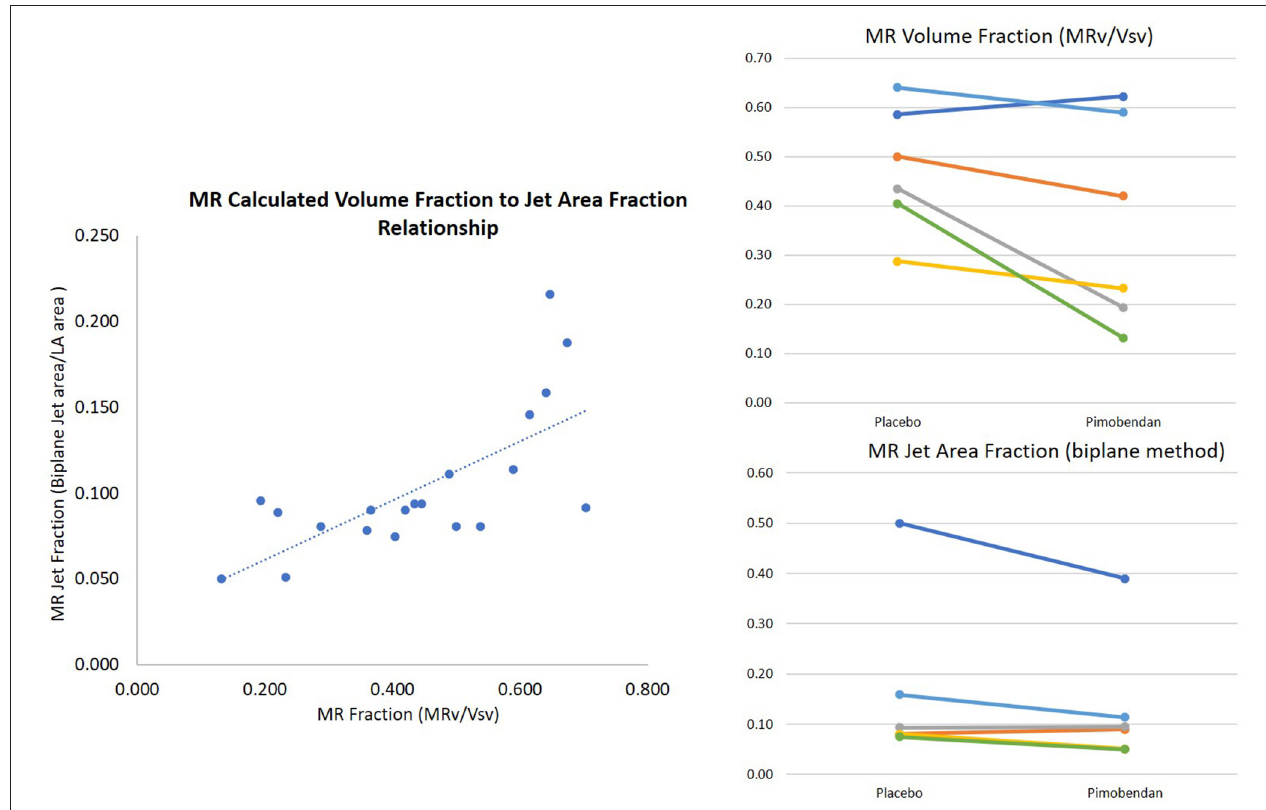
FIGURE 3 | Mitral regurgitation quantification. Methods were positively correlated ( r = 0.7 with high outlier removed) and found decreases in mitral regurgitation between placebo and pimobendan. Mitral regurgitant area fraction was significantly decreased with Wilcoxon Signed Rank Test p = 0.036. MR volume fraction was normally distributed with p =